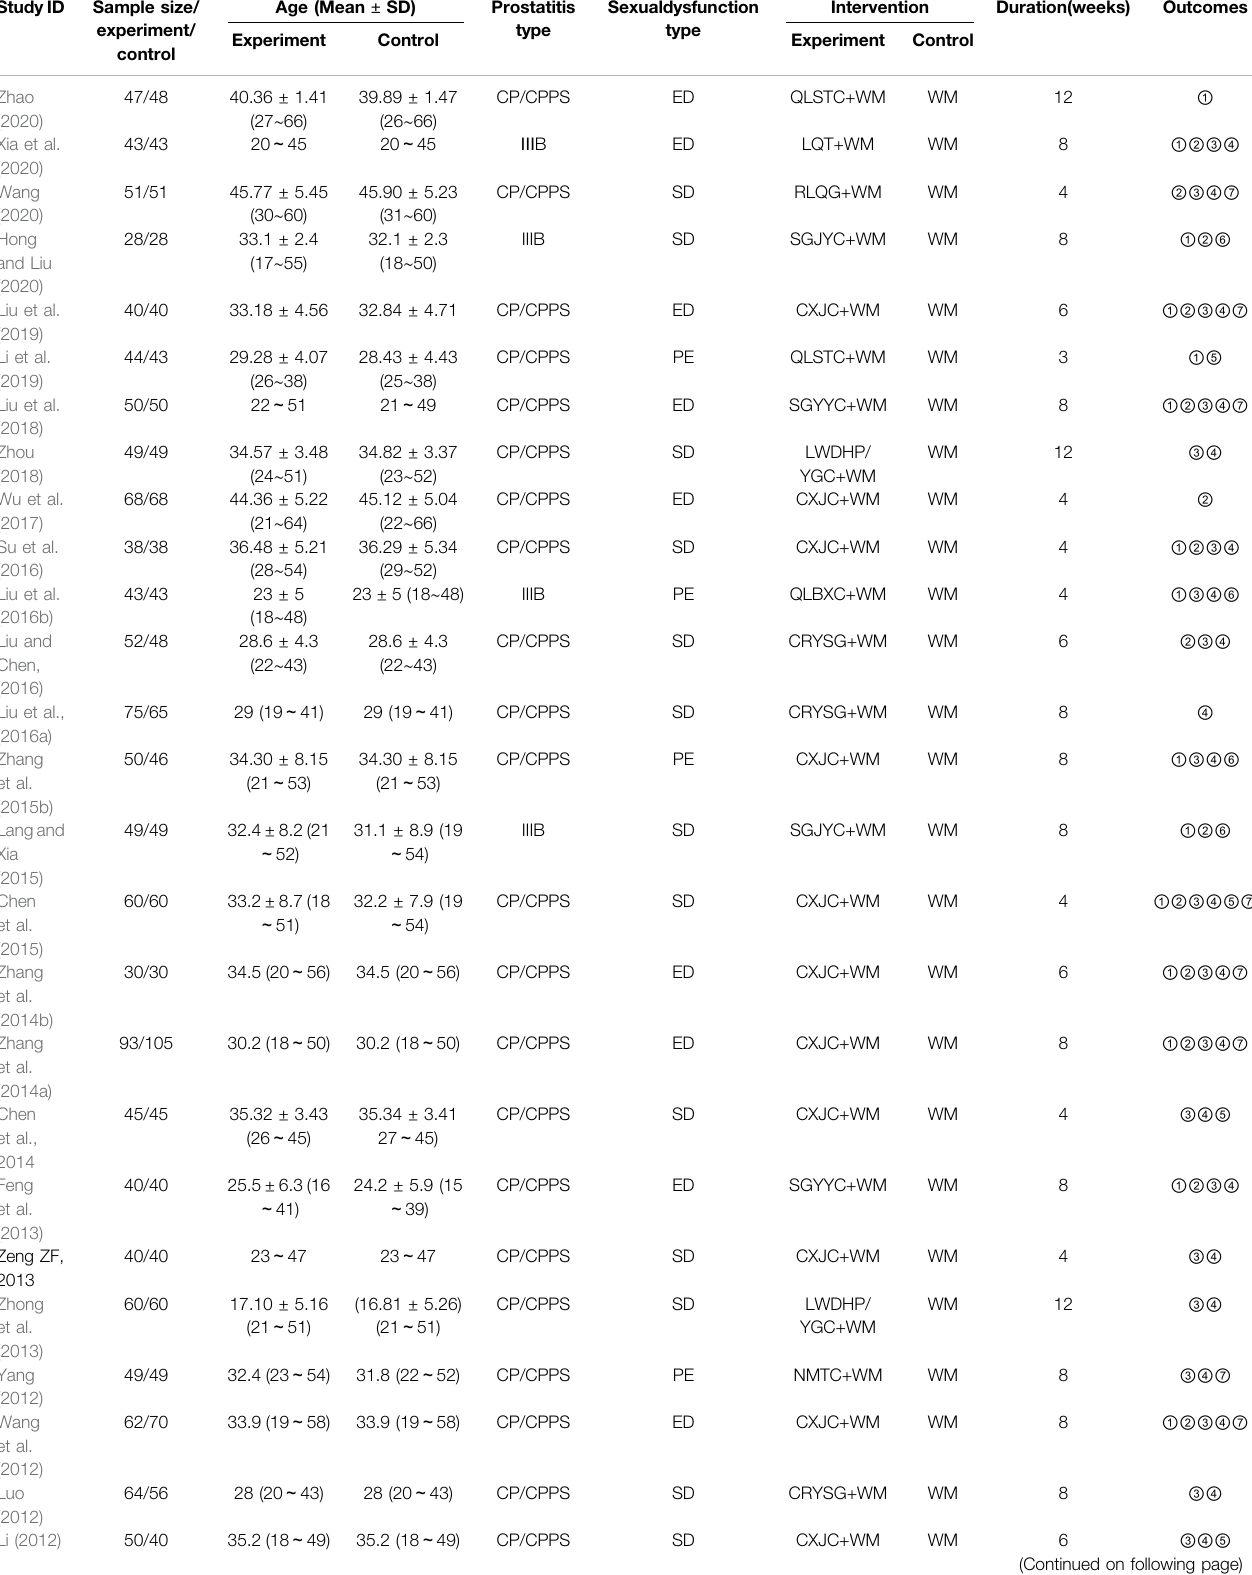
TABLE 1 | Characteristics of included